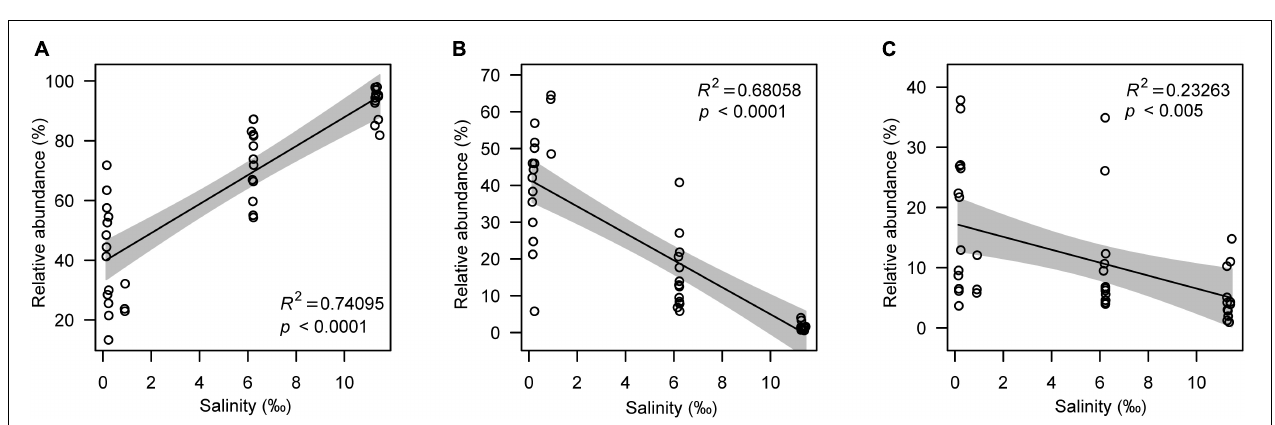
FIGURE 3 | Relationship between salinity and observed OTUs (A) and the Shannon index (B) .